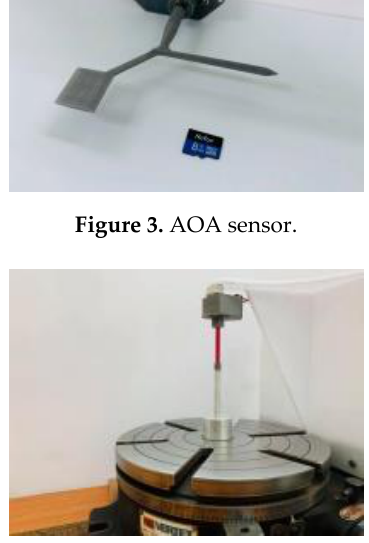
Figure 4. Calibration